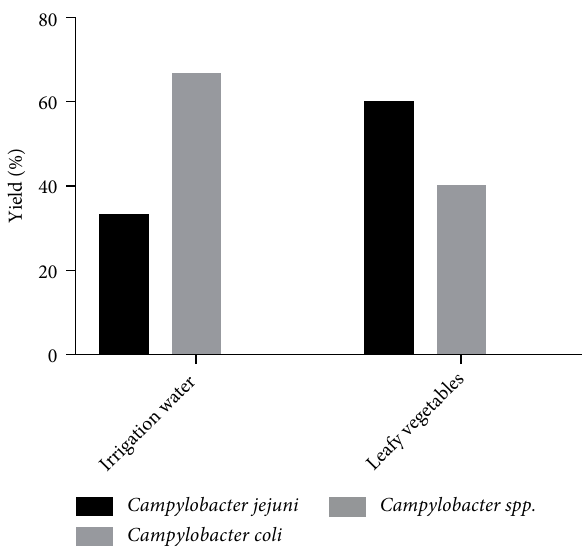
Figure 1: Distribution of Campylobacter species from contaminated garden samples using poultry manure.